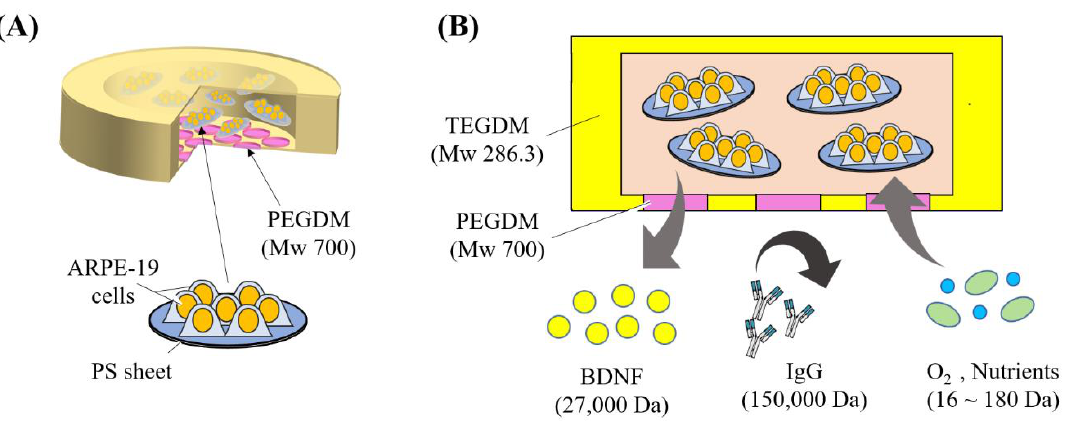
Figure 1. Overview of the cell-encapsulation device. ( A ) A 3D printed capsule with ARPE-19 cells enclosed inside the device. ARPE-19 cells were cultured in polystyrene (PS) sheets. ( B ) Cross-section of device in A. The 3D printed capsule with semi-porous membrane (PEGDM) allowed selective permeability of brain-derived neurotrophic factor (BDNF; 27 kDa), O 2 , and nutrients (16–180 Da) while protecting the cells from the immune response of the body (i.e., immunoglobulin (IgG; 150 kDa)).